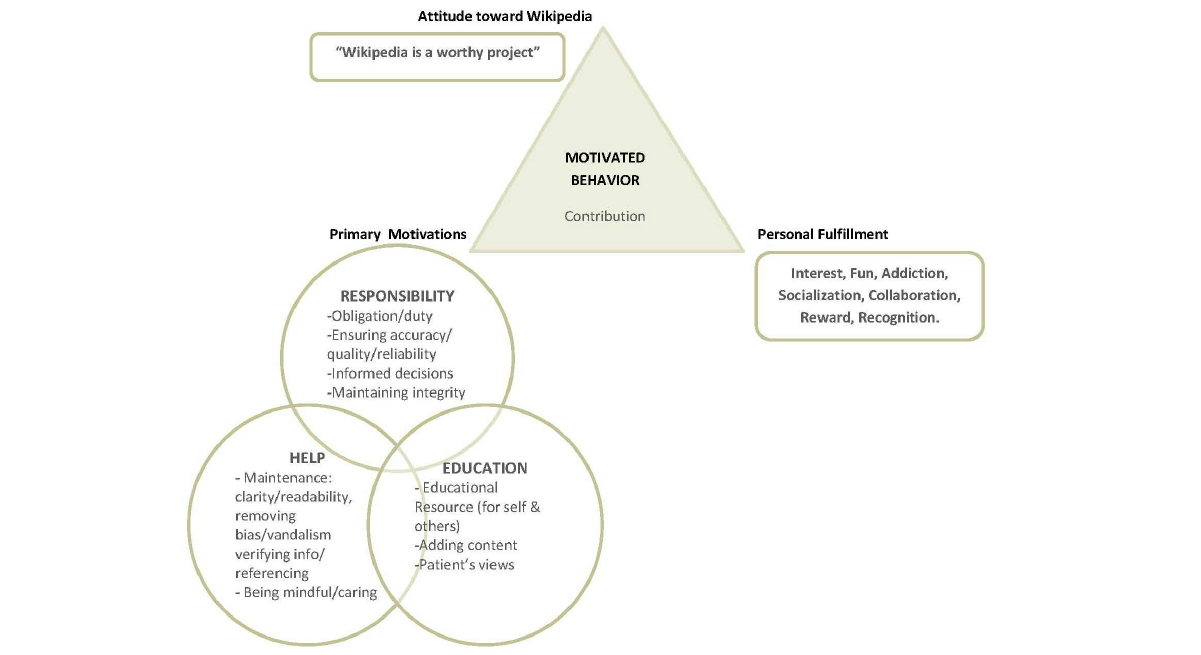
Figure 1. The motivational